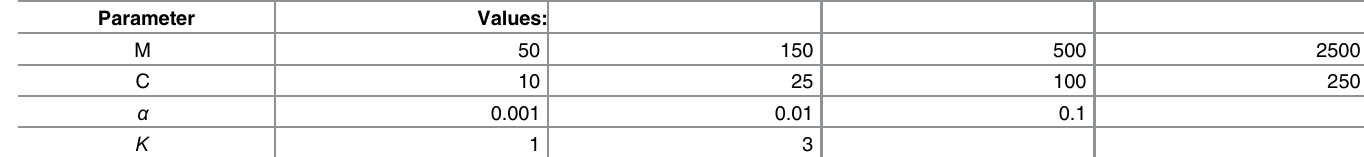
Table 2. Table of simulated parameter values. C is the number of read counts while M , K and α are as in Table 1.